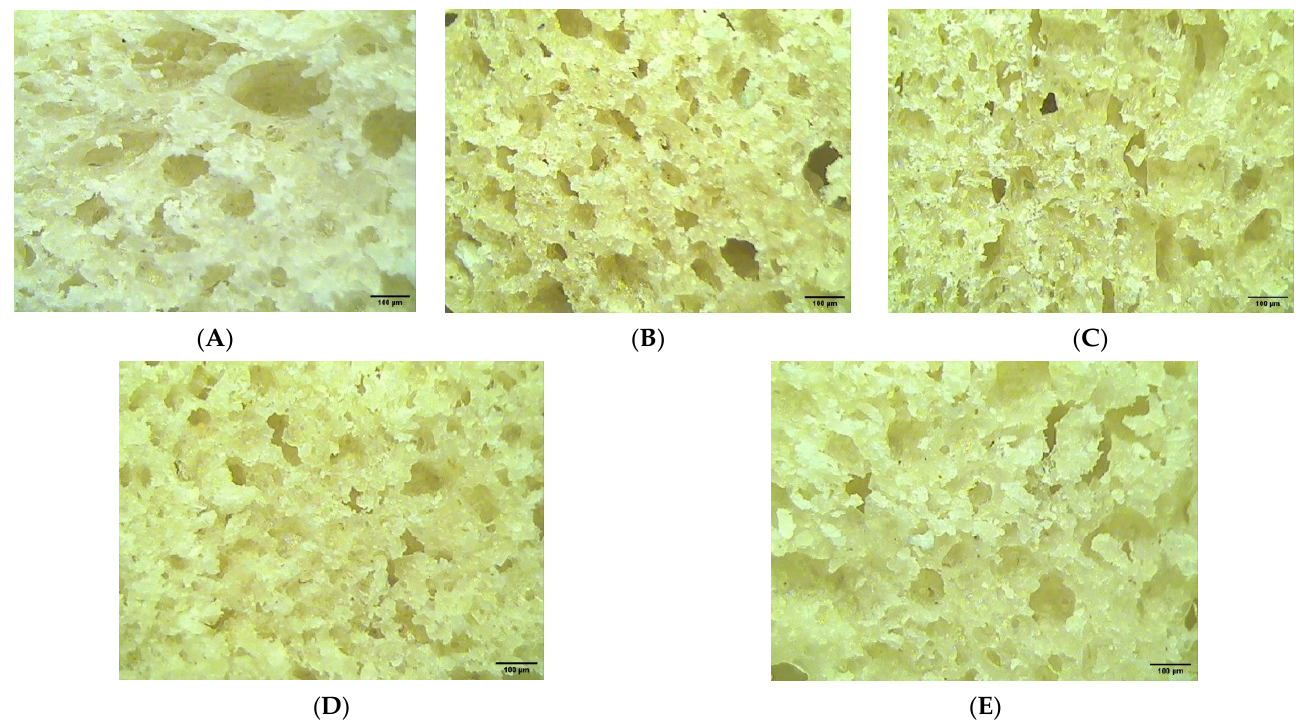
Figure 3. Structure of wheat dough with germinated soybean flour (GSF) at different levels: 0% ( A ),